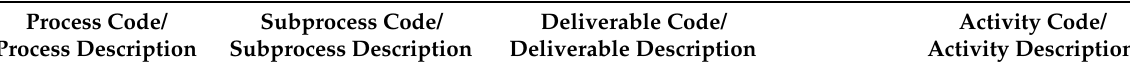
Table 1. Description of the activities of process groups G1.1 and